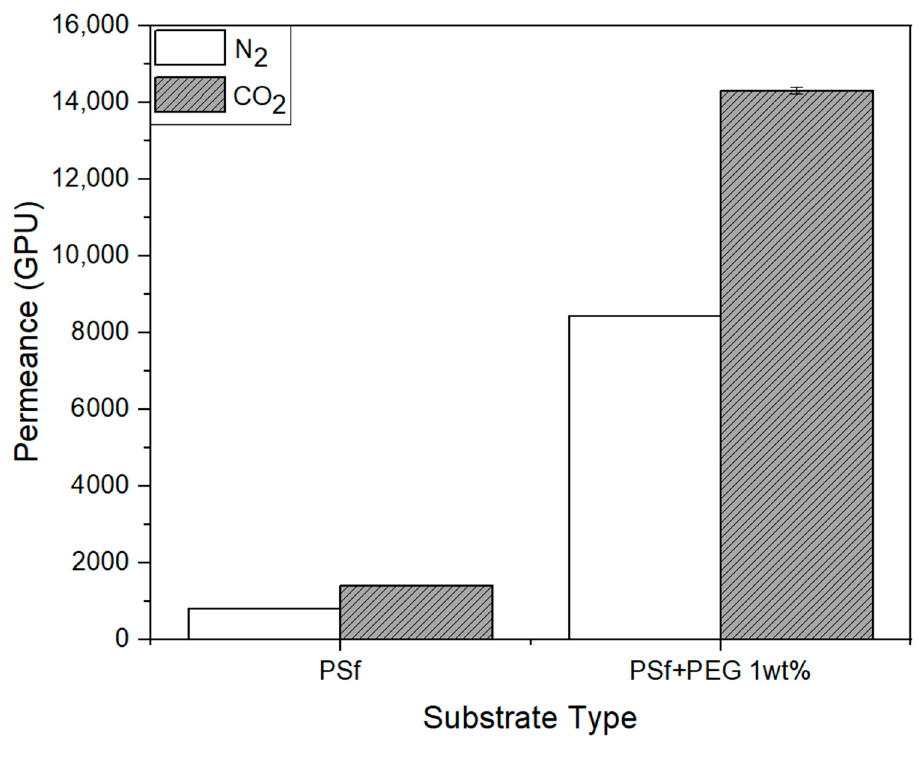
Figure 13. Gas permeance of PSf and PSf+PEG 1 wt% substates. Table 4. Gas permeation properties of two